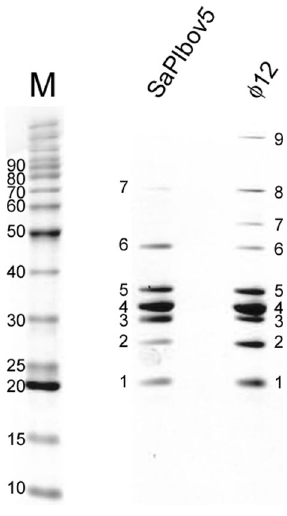
Fig. 3 Identi fi cation of ϕ 12 and SaPIbov5 proteins. SDS-PAGE separation of proteins from ϕ 12 and SaPIbov5 procapsids. M, markers, molecular weights indicated (kDa). The bands that were selected for MS analysis are numbered. See Table